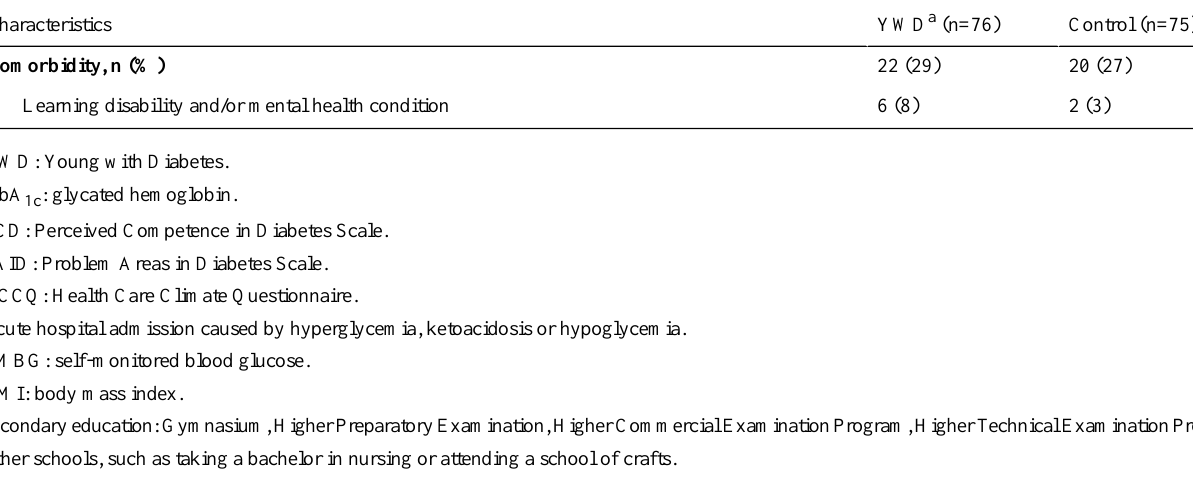
Figure 2. Mean glycated hemoglobin (HbA 1c ) levels in control and Young with Diabetes (YWD) groups at 2, 7, and 12